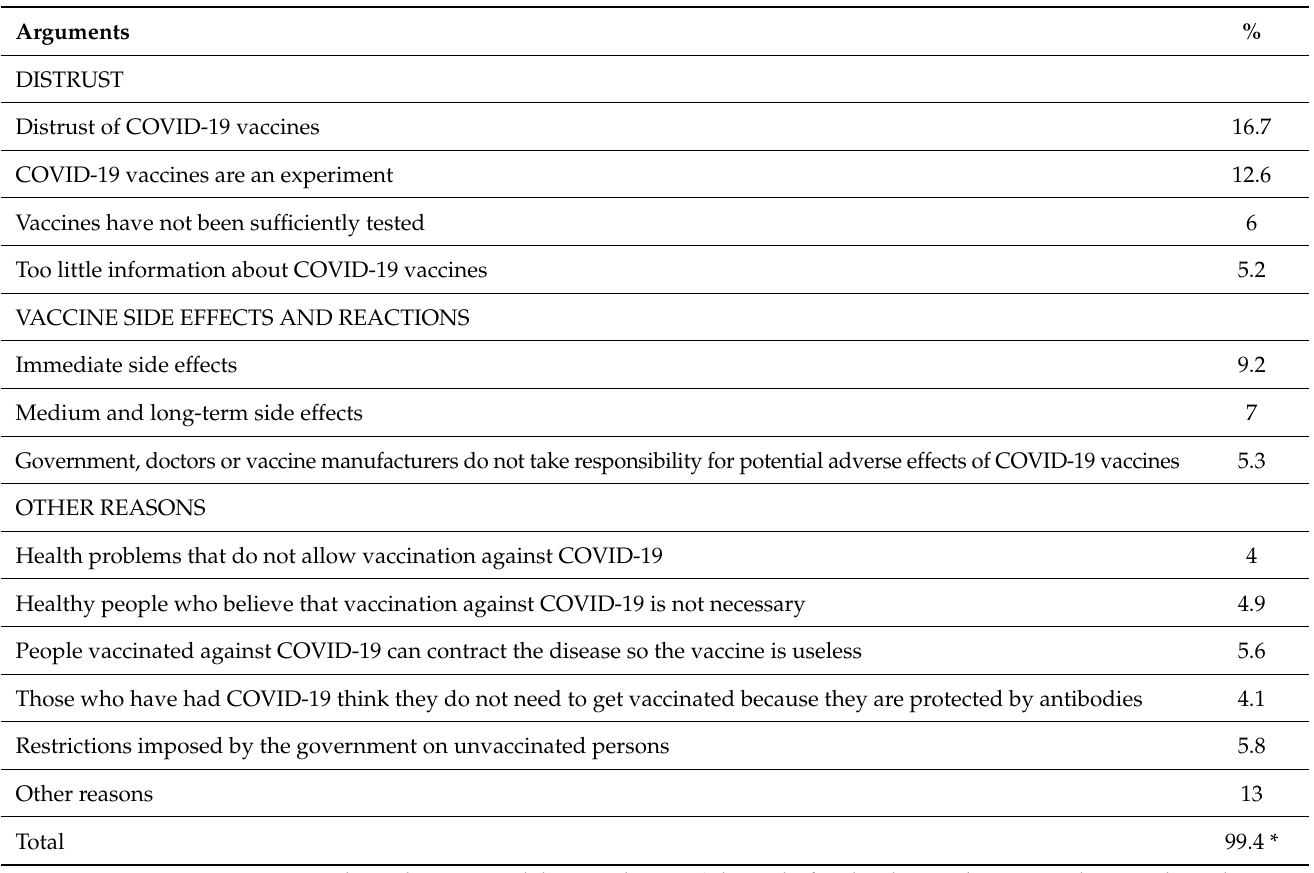
Table 2. Data setting out the main reasons given by the persons when arguing for the non- vaccination